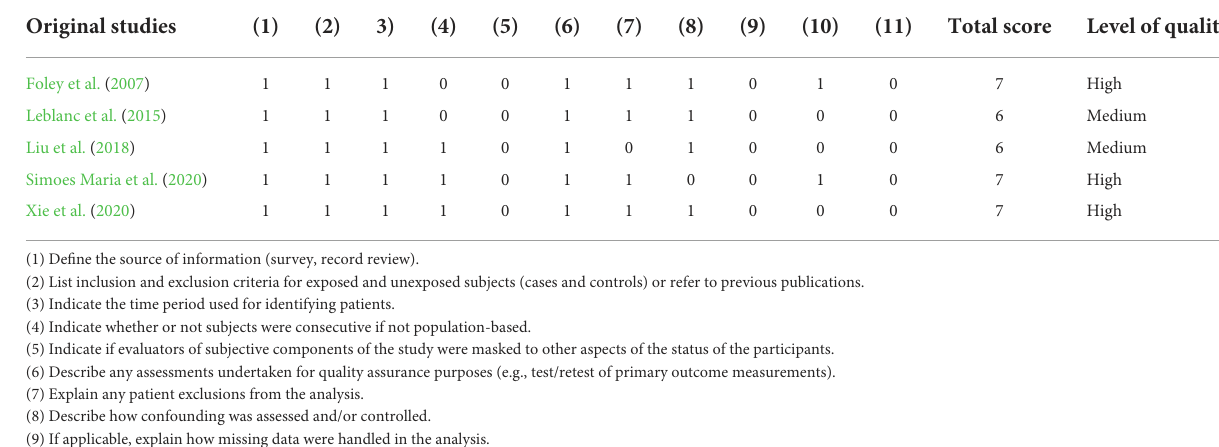
TABLE 3 Quality assessment of included cross-sectional studies.